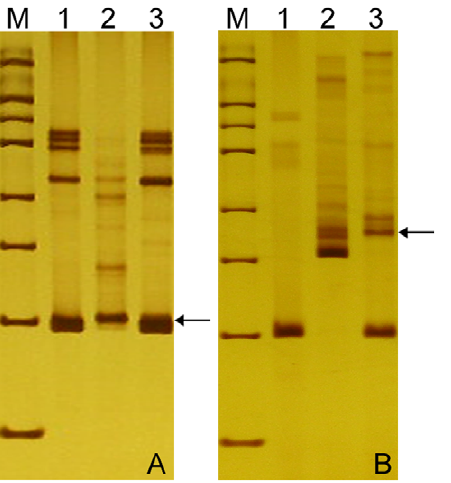
Figure 4. Identification of Psathyrostachyshuashanica chromo- somes using EST-SSR and EST-STS markers in disomic addition line 59-11 and its parents, wheat cv. 7182 and Psathyrostachys huashanica . a SWES2 and b CD452568 amplified specific bands in the addition line in chromosomes 6A, 6B, and 6DS, and, 6AL, 6BL, and 6DL, respectively (arrows). M marker, 1 Psathyrostachys huashanica , 2 7182, 3 chromosome addition line 59-11. Arrows indicate the diagnostic amplification products of Psathyrostachys huashanica